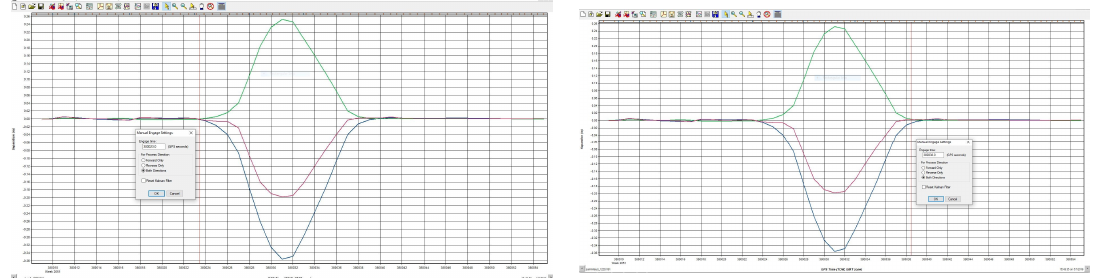
Figure 11. View the obstructed time of